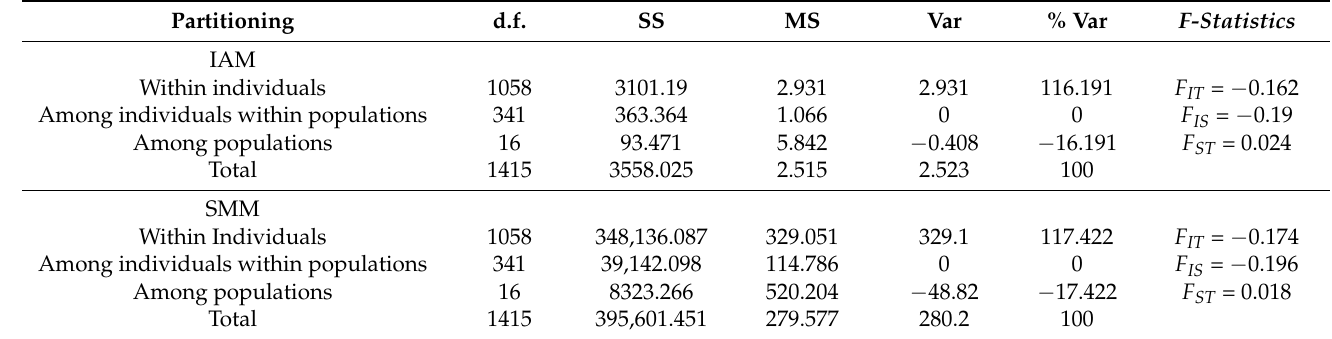
Table 2. Analysis of molecular variance (AMOVA) in Phytophthora colocasiae based on 11 SSR